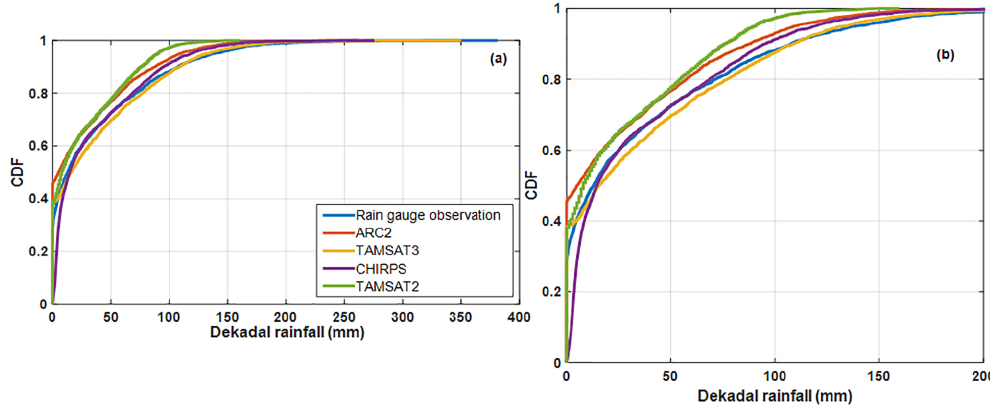
Figure 3. Cumulative distribution function (CDF) of dekadal rainfall for (a) ground rainfall observation, ARC 2, TAMSAT, and CHIRPS rainfall estimates and (b) magnified view of their CDF for 0 to 200mm part over the Upper Blue Nile basin for the period of 2000–2015.